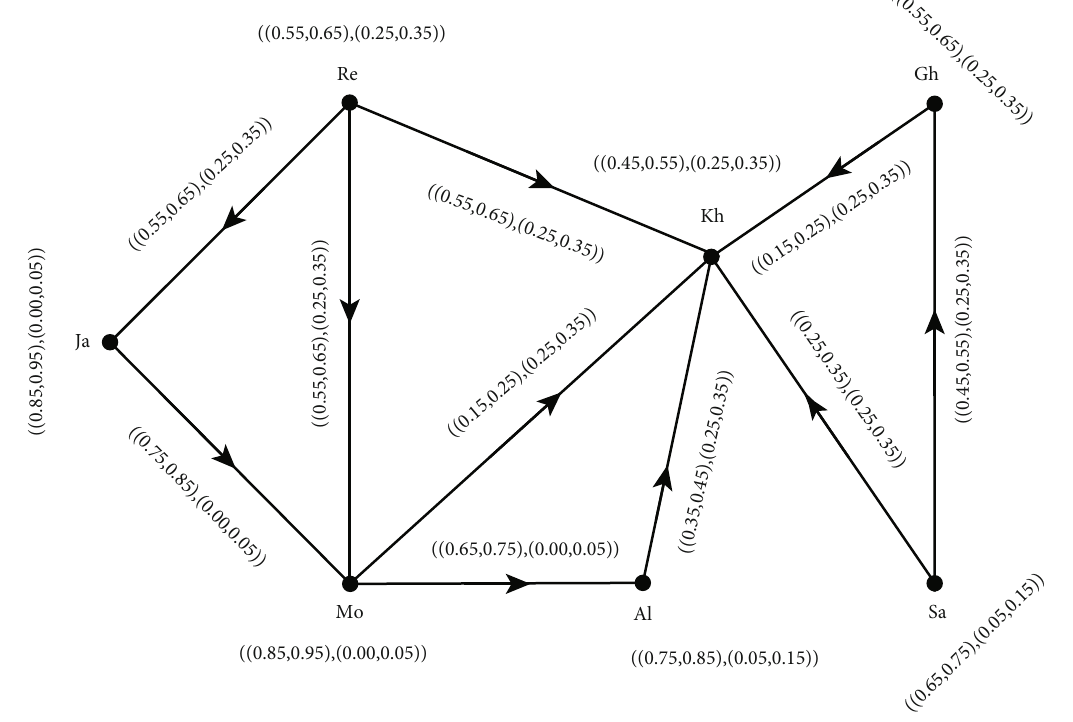
Figure 11: IVIF digraph (in fl uence graph). Table 4: Adjacency matrix corresponding to Figure